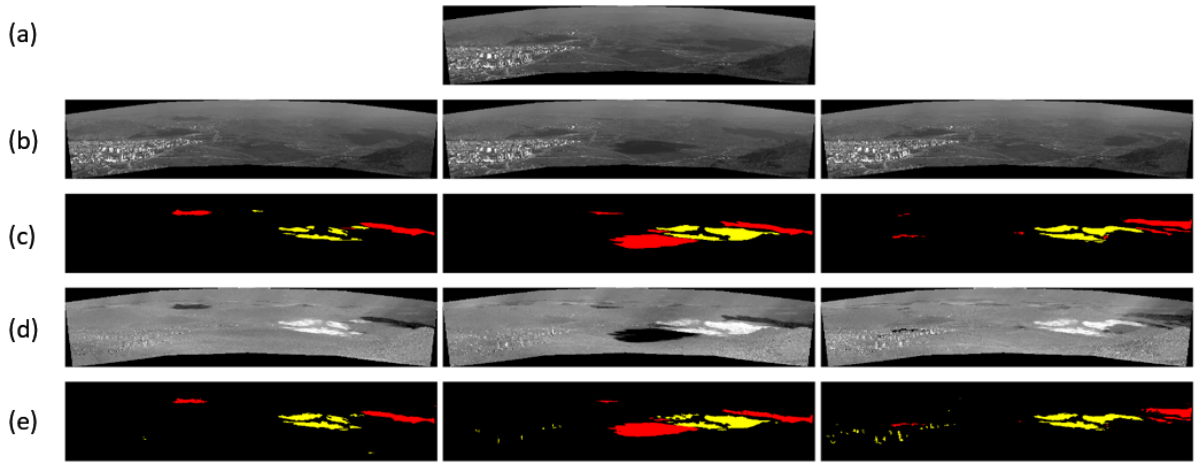
Figure 5. Moving Cloud Shadow Detection Stages for a Single Dataset: (a) Background Image, (b) Images Including the Moving Cloud Shadows, (c) Ground Truth Masks, (d) Quotient (Reflectance Ratio) Images, (e) Moving Cloud Region Detection Results